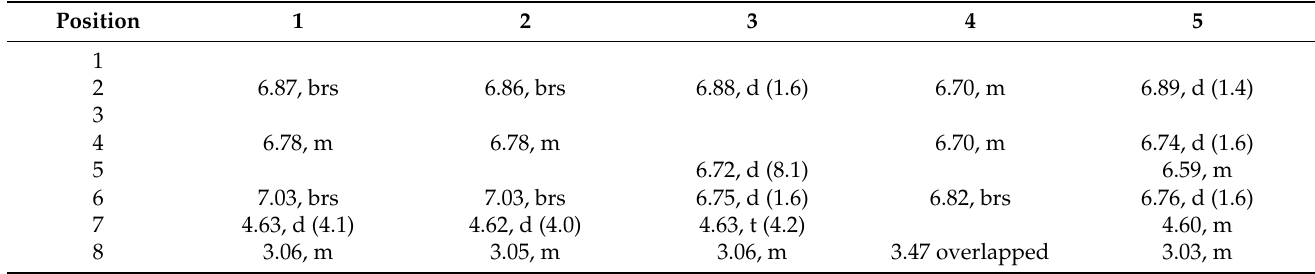
Figure 1. Structures of compounds 1 – 5.